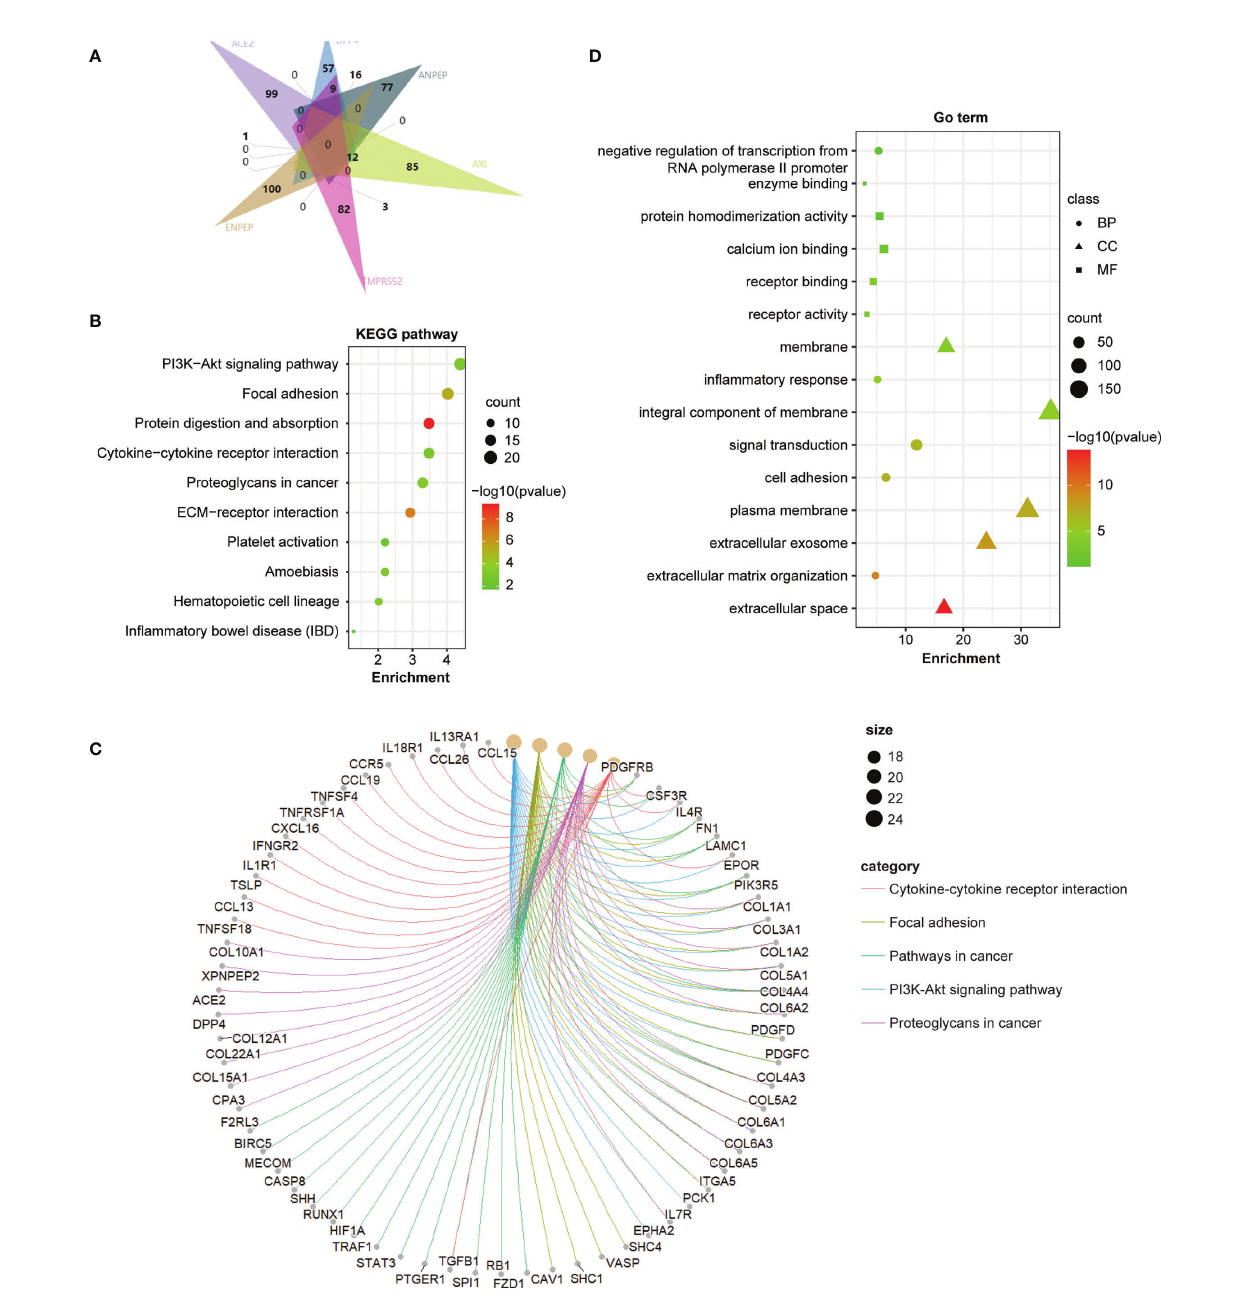
FIGURE 5 | Coronavirus receptor-related gene enrichment analysis in GBM. (A) An intersection analysis of the top 100 receptor-correlated genes with GBM among different receptor groups according to the E Venn diagram. (B) Bubble chart for KEGG enrichment pathway analysis based on total receptor-related genes. (C) The cnetplot of all genes in the yellow module that depicts the linkages of genes and the most important signaling pathways. (D) Functional and molecular processes related to coronavirus receptor-related genes in